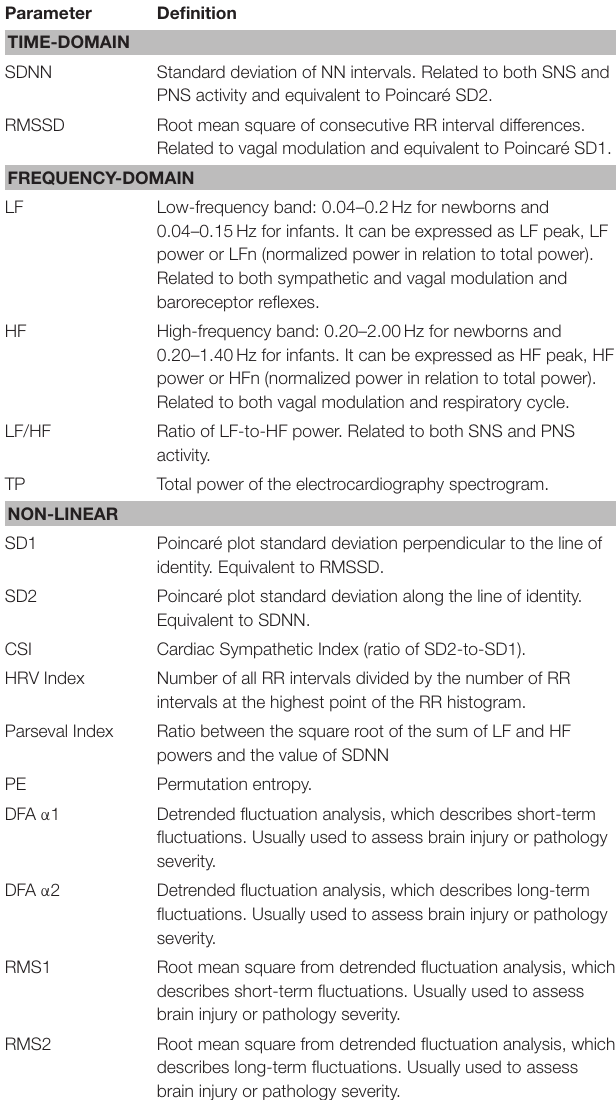
TABLE 1 | Summary of the HRV metrics cited in the main text (Brändle et al., 2015; Massaro et al., 2017; Oliveira et al., 2019; Patural et al., 2019; Frasch et